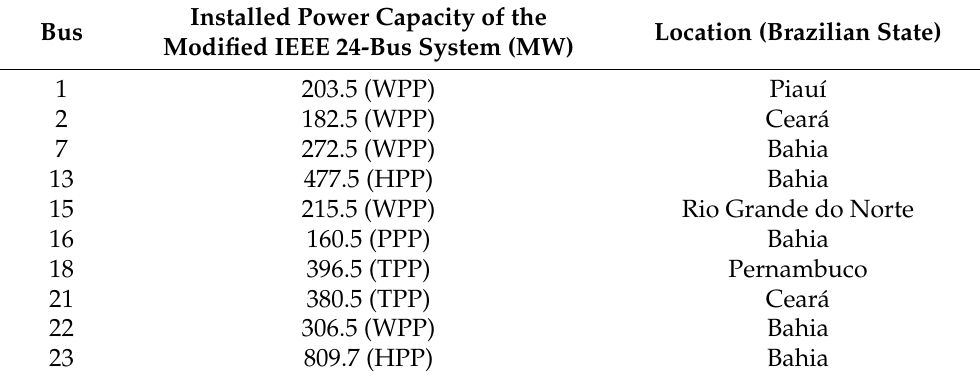
Table 2. Final installed power capacity of the modified IEEE 24-bus.